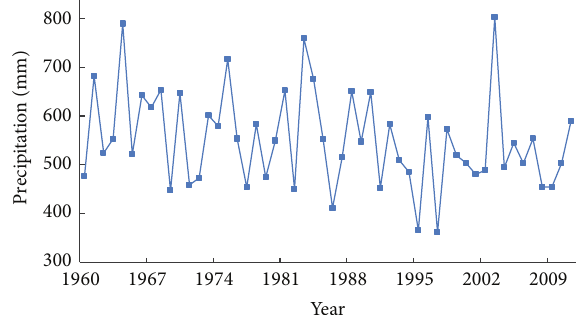
Figure 3: Estimated annual precipitation in the Weihe River basin from 1956 to 2011.